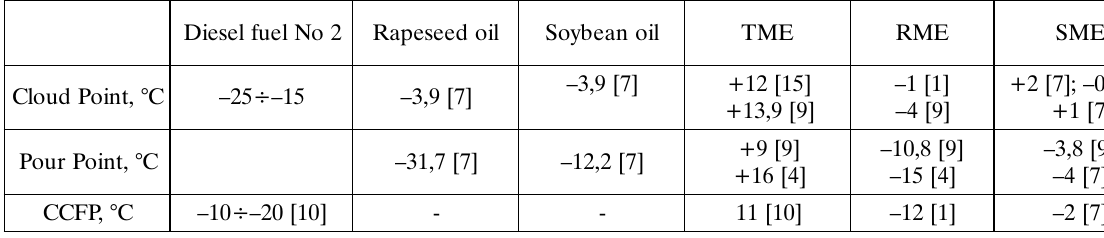
Table 8. Flash Point of fuel